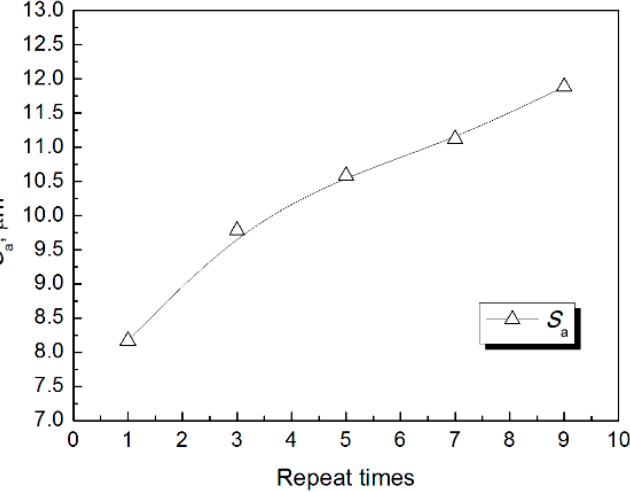
Figure 9. Surface roughness after laser milling with different numbers of milling processes.